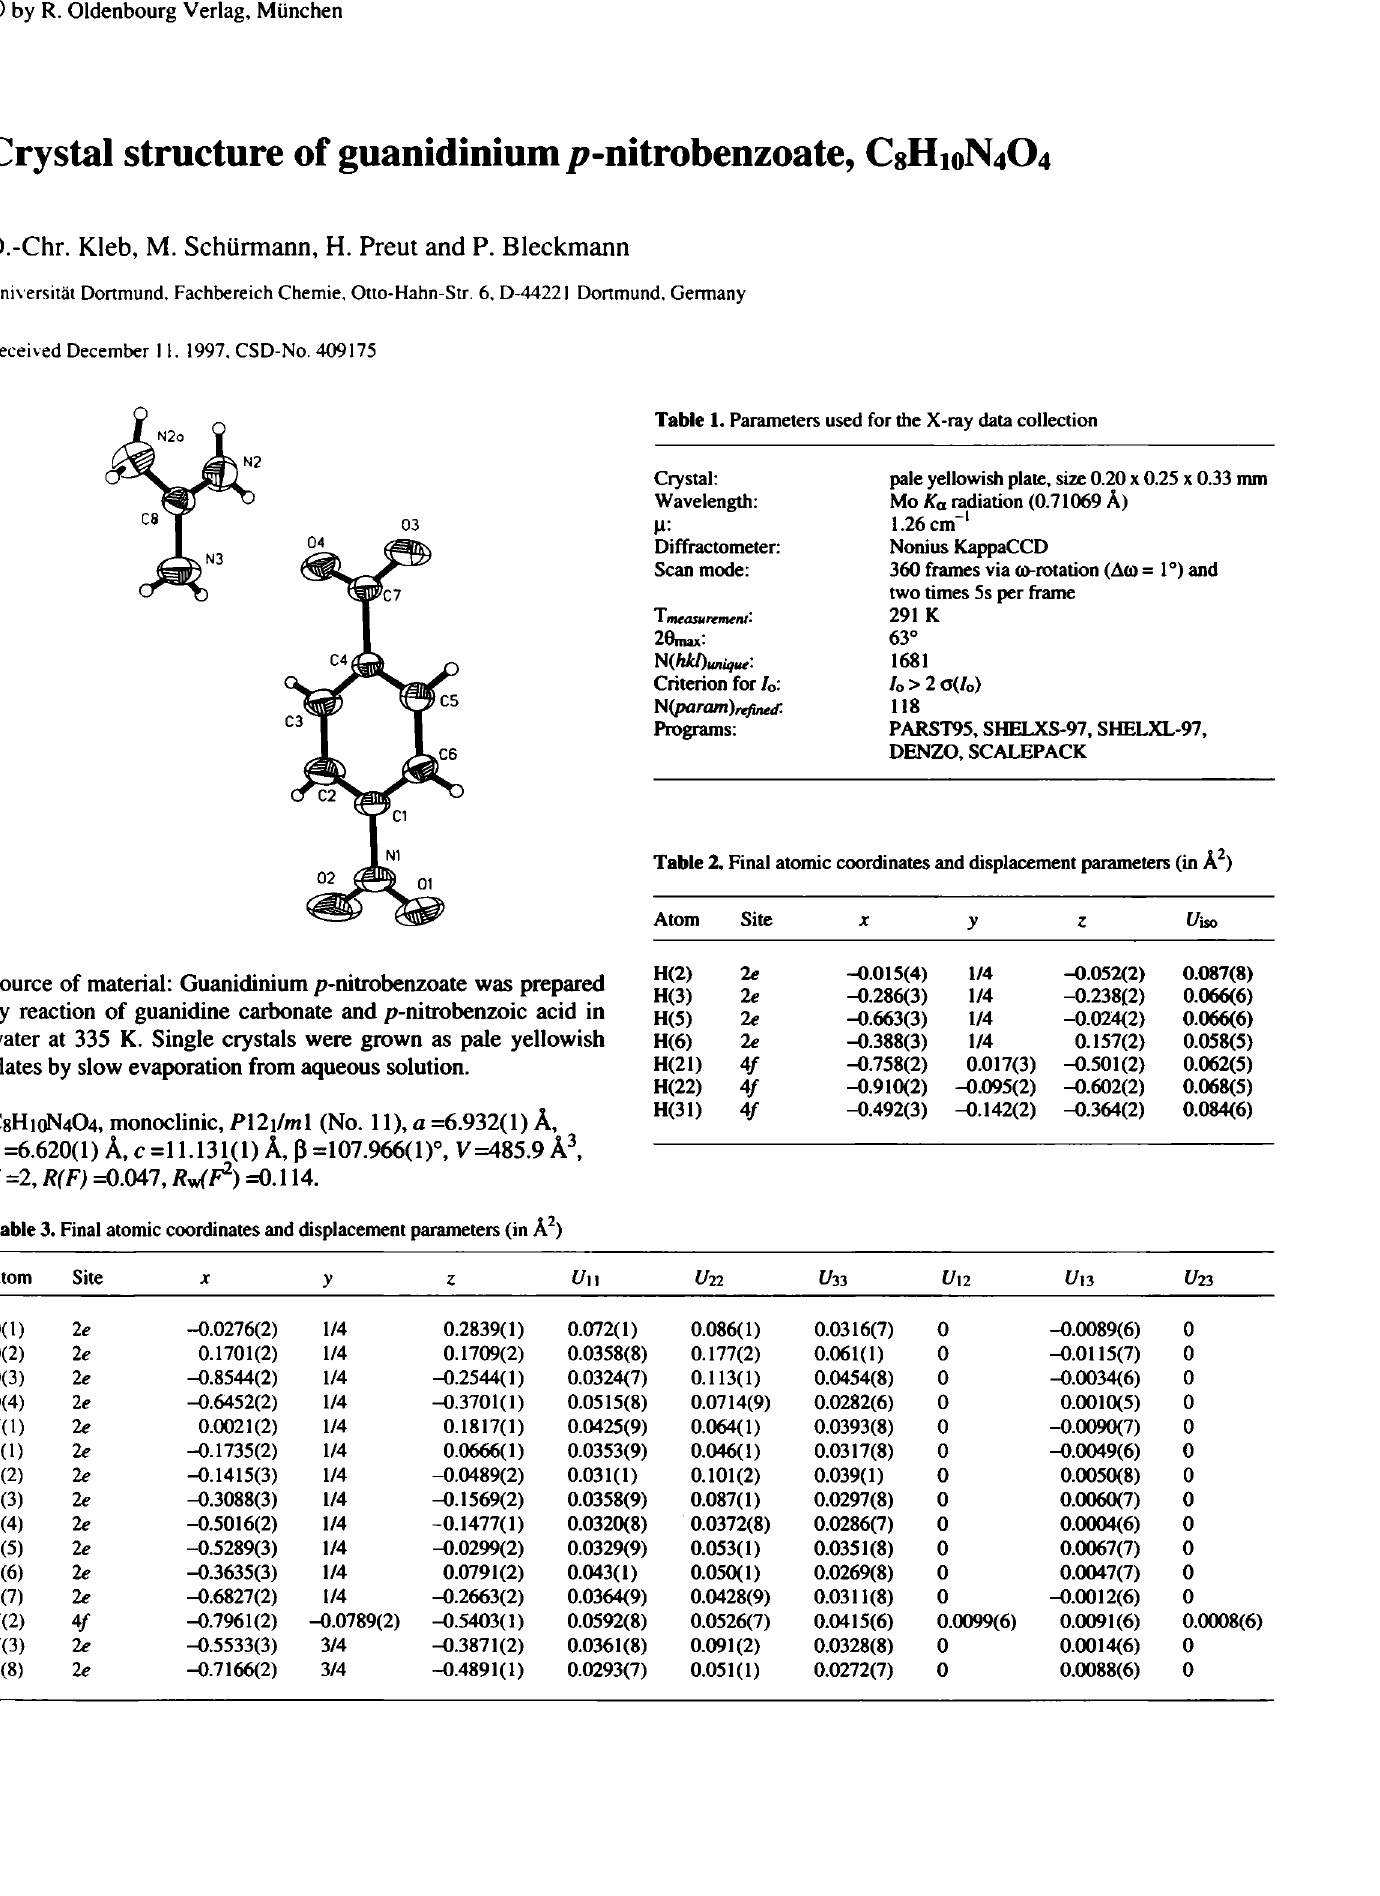
Table 1. Parameters used for the X-ray data collection